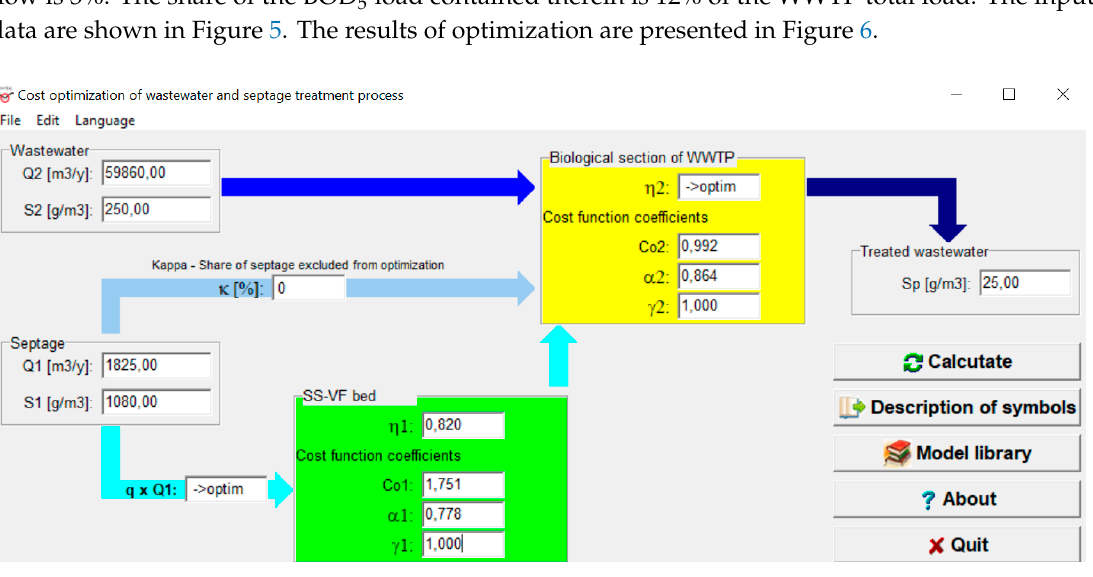
Figure 5. Computer program “Cost optimization of wastewater and septage treatment process”, example 1—summary of the input data .